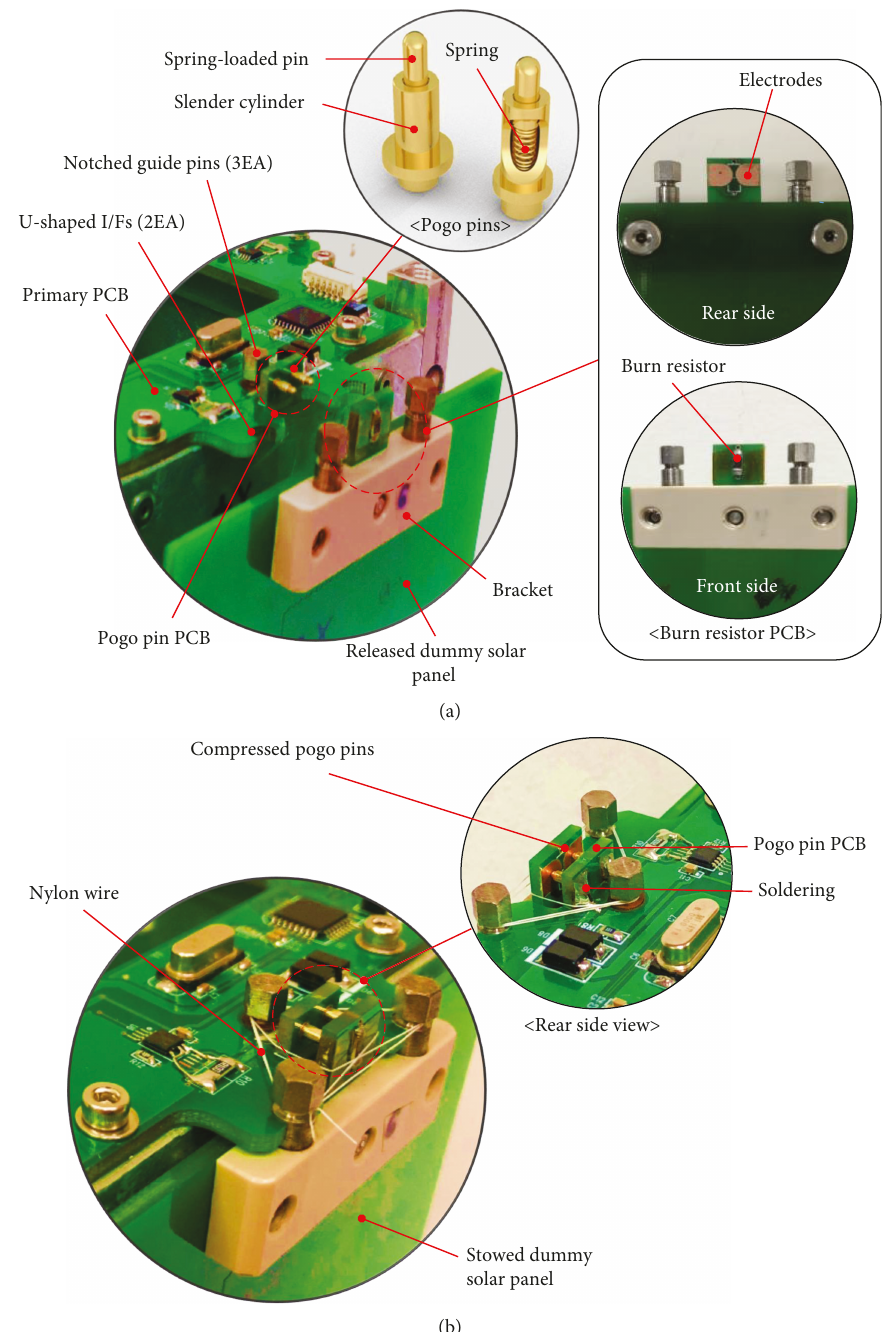
Figure 2: Enlarged con fi guration of pogo pin mechanism: (a) partially stowed and (b) fully